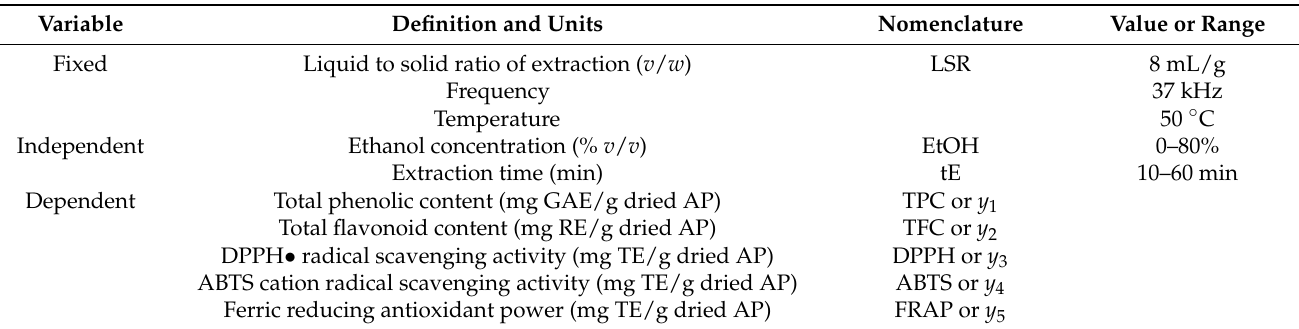
Table 1. Experimental variables used in this study.